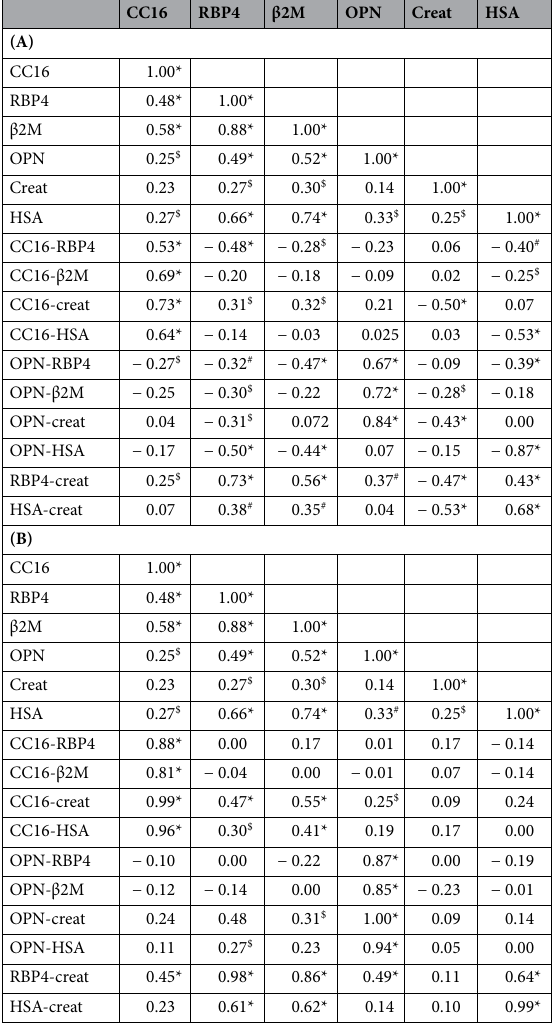
The adjustment by simple division with the potential adjuster (Table 3(A)) was compared with the adjustment on the basis of the regression coefficient between the two analytes (Table 3(B)). The values of U-CC16 correlated with the potential adjusters, β2M and RBP4 (resp. r = 0.58, p < 0.001 and r = 0.48, p < 0.001), but according to the method of adjustment, i.e. simple division or adjusting on the basis of the regression coefficient, the correlation pattern differed noticeably. For instance, when expressing U-CC16 as a ratio to U-β2M, not surprisingly, there was a good correlation between U-CC16/U-β2M and unadjusted CC16 (r = 0.69, p < 0.001). However, some residual correlations persisted with the adjuster U-β2M (r = −0.18, p = 0.15), but also with U-HSA (r = −0.25 , p < 0.05) and U-RBP4 (r = −0.20, p = 0 . 11). By contrast, when adjusting U-CC16 using the observed regression coefficient between U-βM2 and U-CC16, no residual correlation with U-β2M (r = 0.00, p = 0 . 99) and lower residual correlations for U-HSA (r = −0.14, p = 0 . 28) and U-RBP4 (r = −0.04, p = 0 . 75) were observed. Of note, the adjustment of U-CC16 as a ratio to β2M or using the regression coefficient with β2M almost abolished the correlations with U-Creat (r = 0.02, p = 0 . 89 and 0.07, p = 0 . 58, resp.). Additionally, an even better correlation between U-CC16 adjusted with U-β2M and U-CC16 was obtained (r = 0.81, p < 0 . 001). Similar patterns of cor- relations were observed for U-RBP4 as adjuster but with a tendency to more residual correlations, in particular with U-β2M and U-Creat (Table 3). OPN, a protein with similar size as CC16, also showed similar correlation results as obtained for U-CC16, although less pronounced (Table 3).